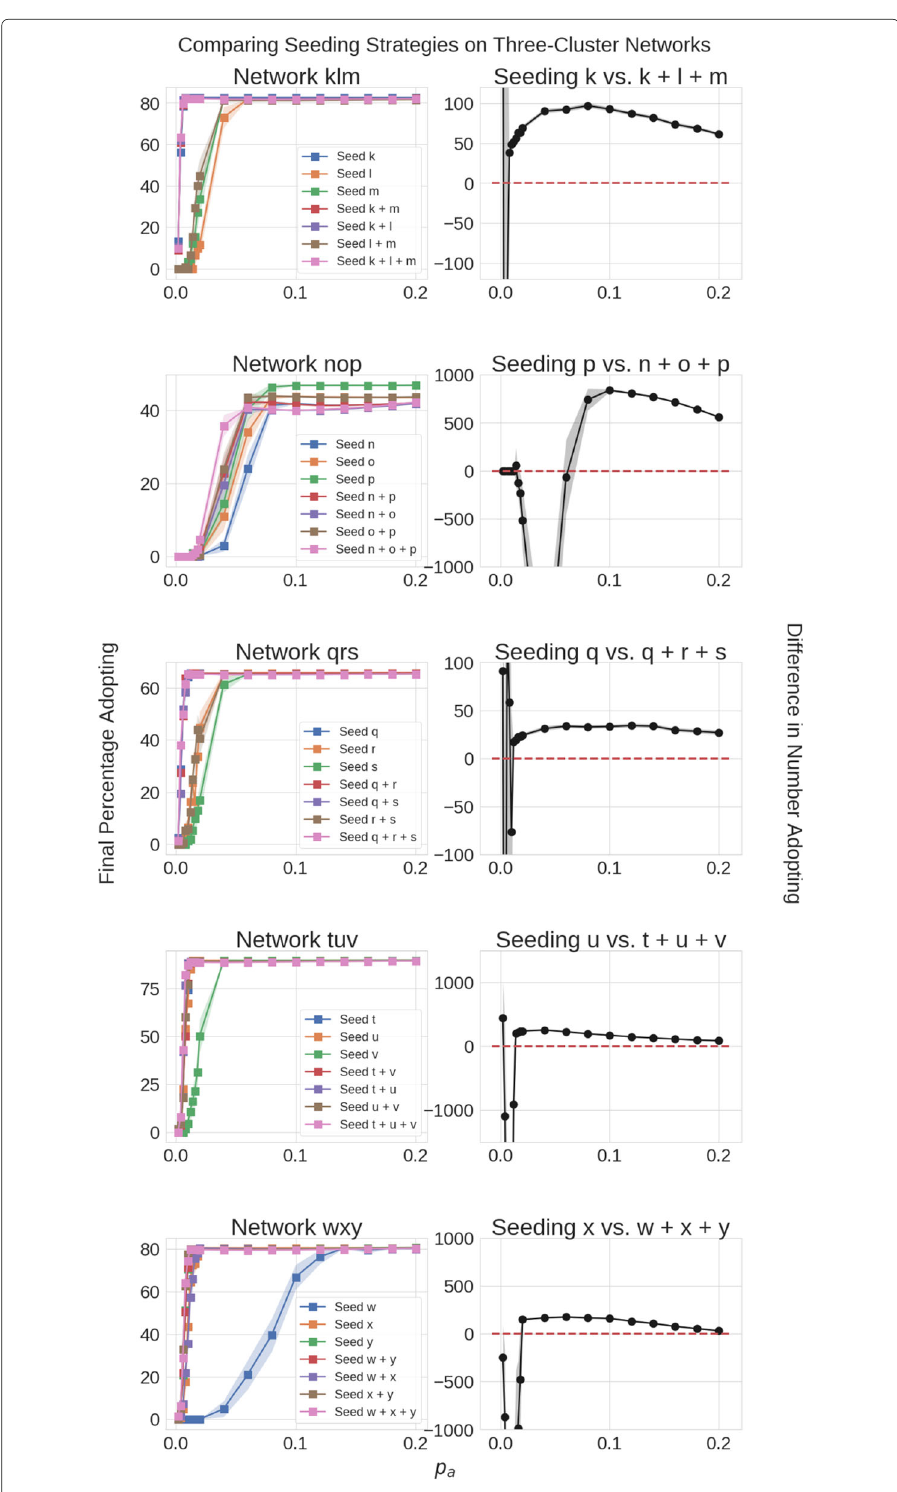
Fig. 4 Comparison of cluster-based seeding approaches in the threshold model. Different rows correspond to different three-cluster networks from Table 2. The left-hand column shows the final percentage of the network adopting under various cluster-based seeding strategies; the right-hand column shows the difference in the number adopting under seeding the single cluster with the highest median degree vs. all three clusters. The parameter s i = 5 in these simulations. Each data point is an average over 100